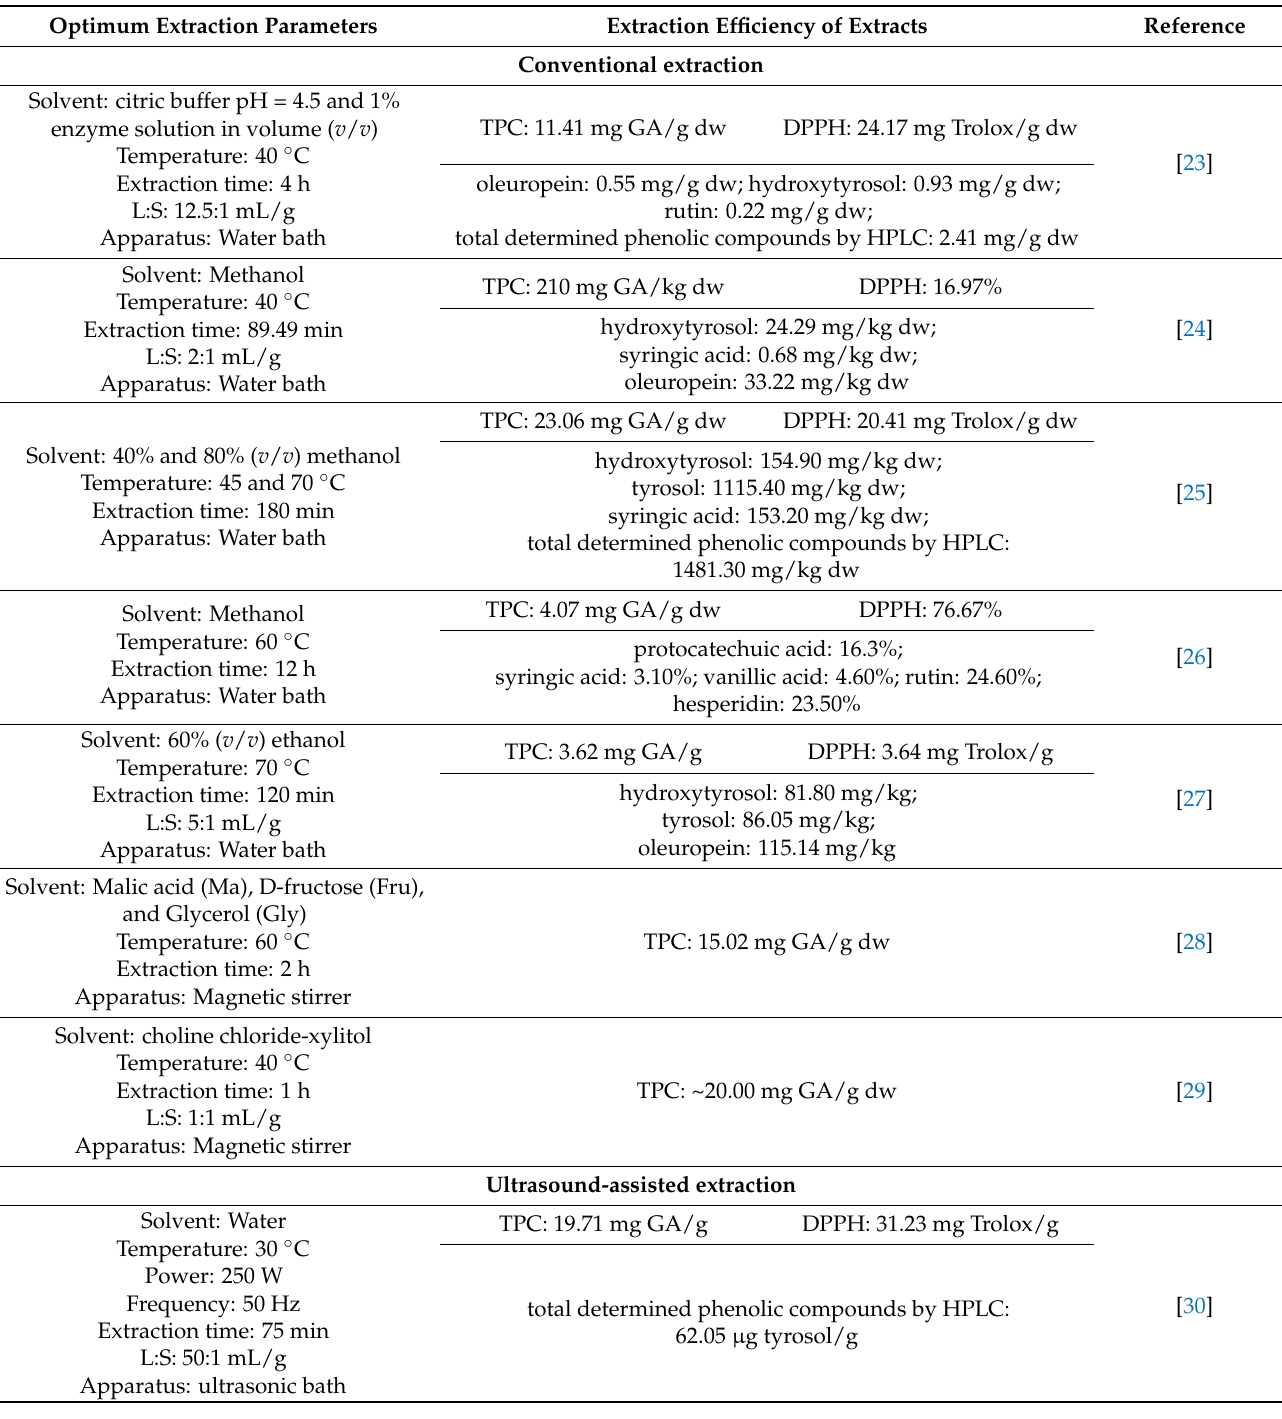
Table 2. Extraction of phenolic compounds from olive pomace by conventional and innovative